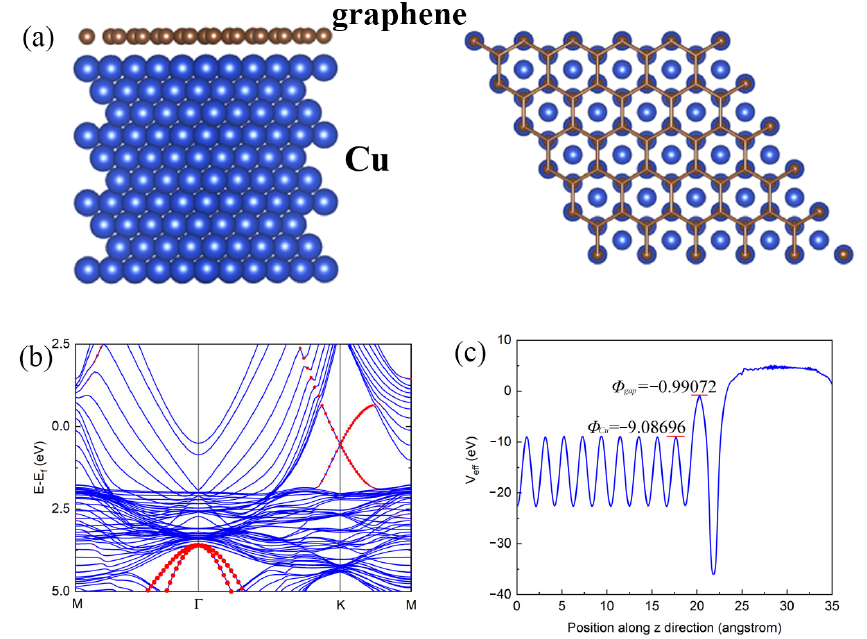
Figure 9. ( a ) Model structure; ( b ) Band structure; ( c ) Average local potential.